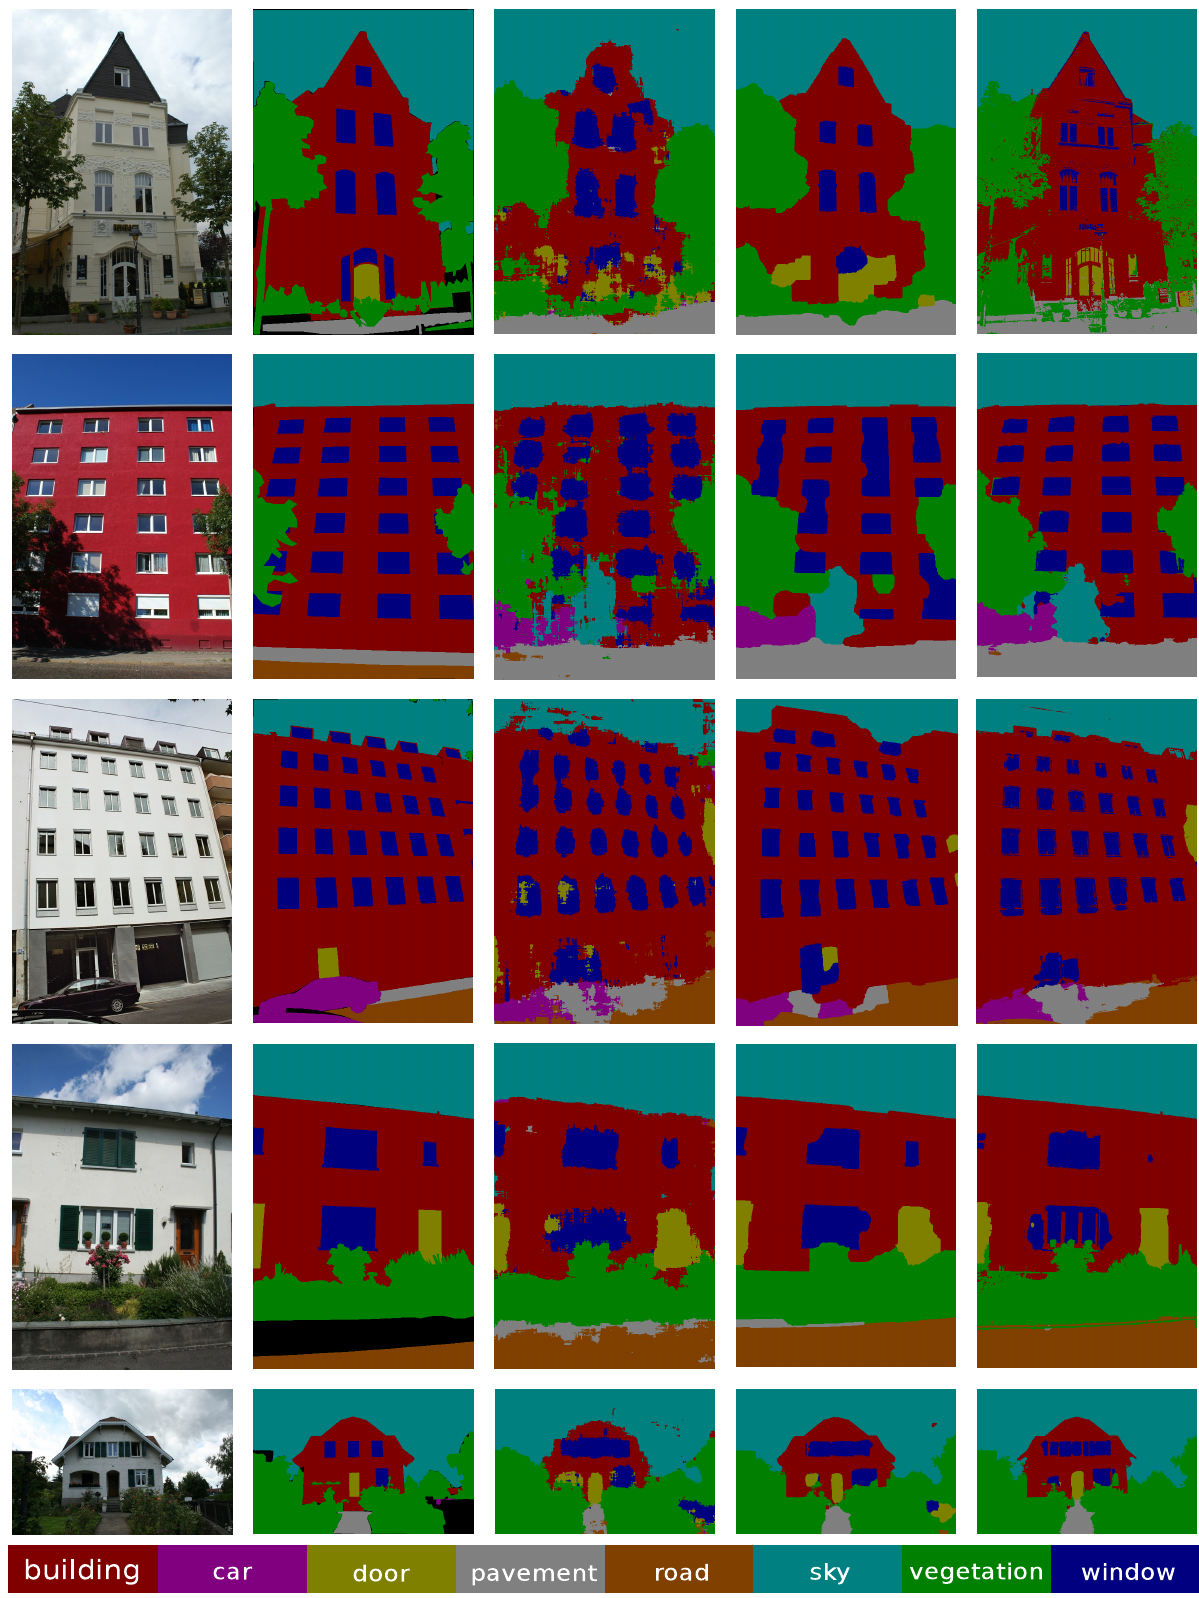
Figure 4. The qualitative results of the eTRIMS dataset. First column are examples of the testing images and 2nd-column are the cor- responding ground truth. (3rd-column to 5th-column) man-made scene semantic segmentation results using the Textonboost classifier, the CRF model and the fully connected CRF model, respectively. The last row is the legend. The fully connected CRF model obtains more accurate and detailed results than the low connected